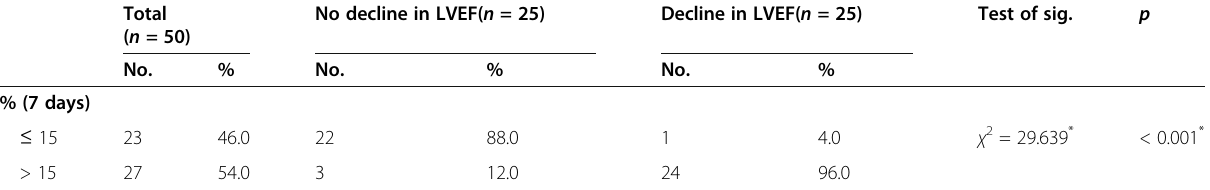
Table 2 Comparison between the two studied groups according STS reduction percentage at 1-week follow-up visit Total No decline in LVEF( n = 25) Decline in LVEF( n = 25) Test of ( n = 50)